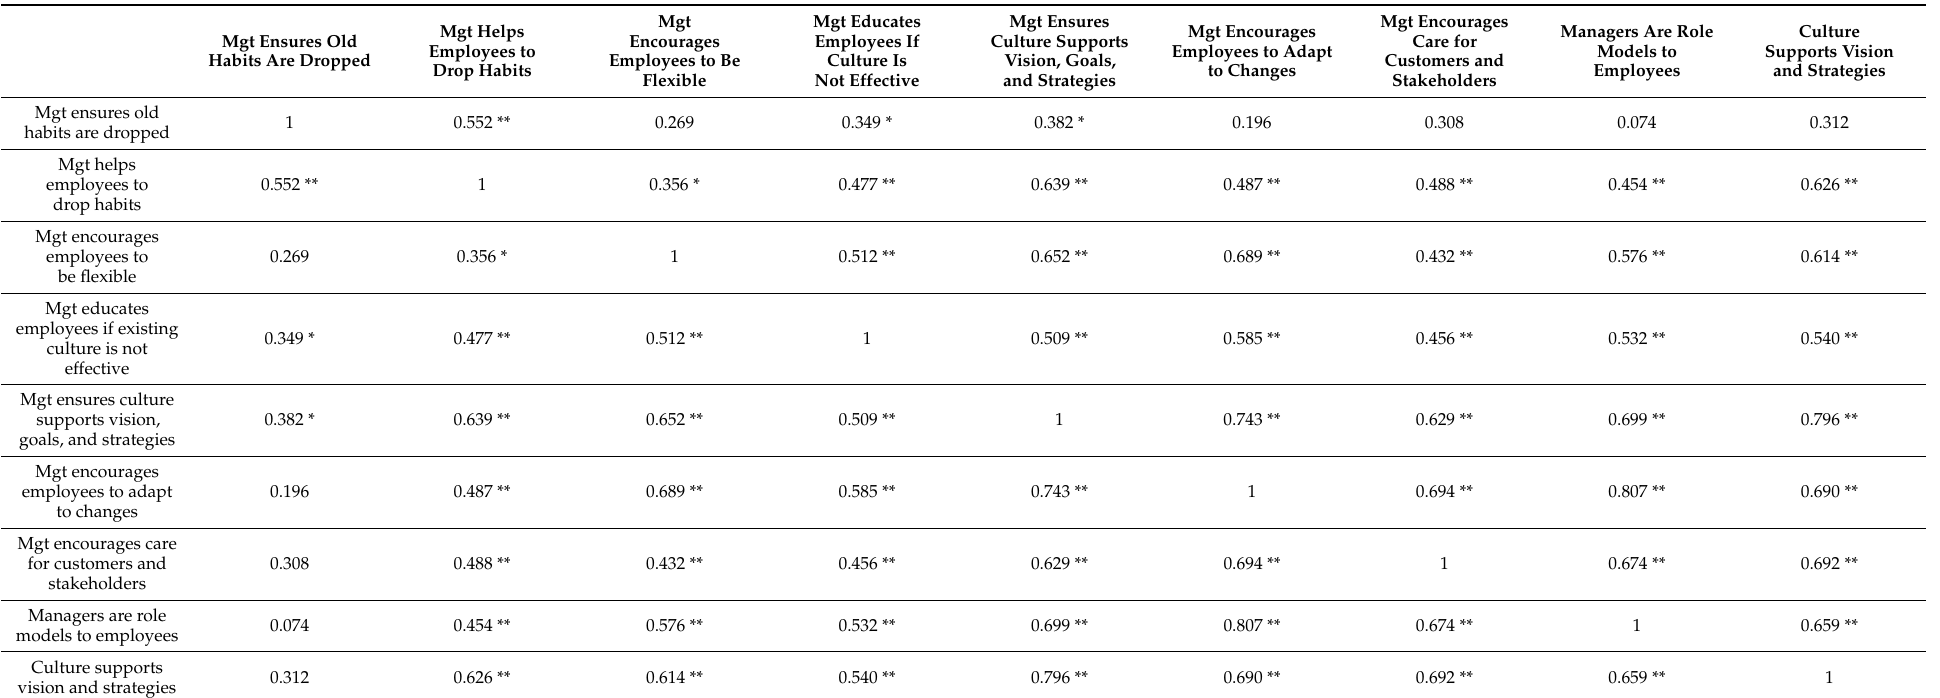
Table 4. Correlation between organizational culture and its effect on